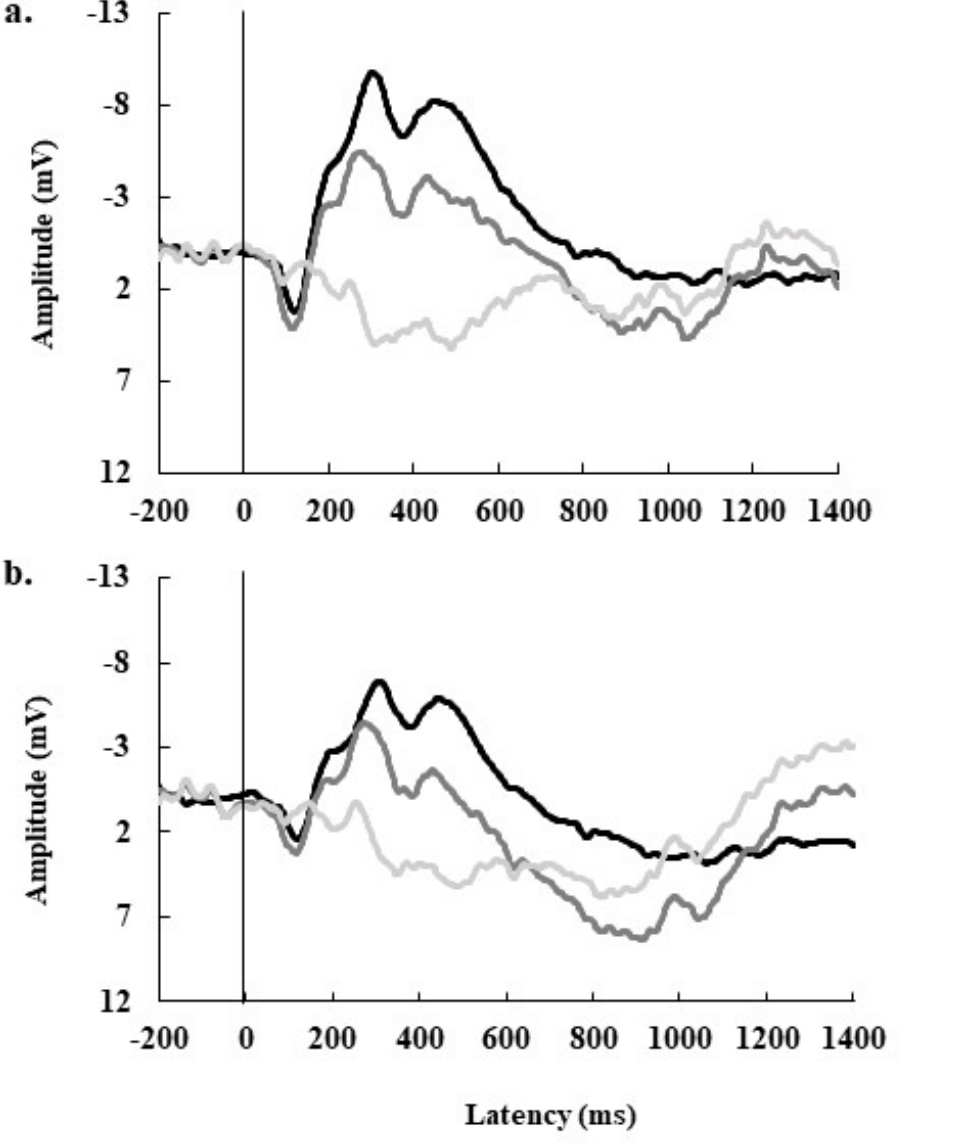
Figure 3. The morphology of the ERP waveforms at electrode at FZ ( a ) and CZ ( b ) are depicted. In each case, the stimulus was presented at 0 ms and is marked with a vertical line. The N2-like component was measured from 150–250 ms post-stimulus ( a ) and the P3-like component was measured from 700–1100 ms post